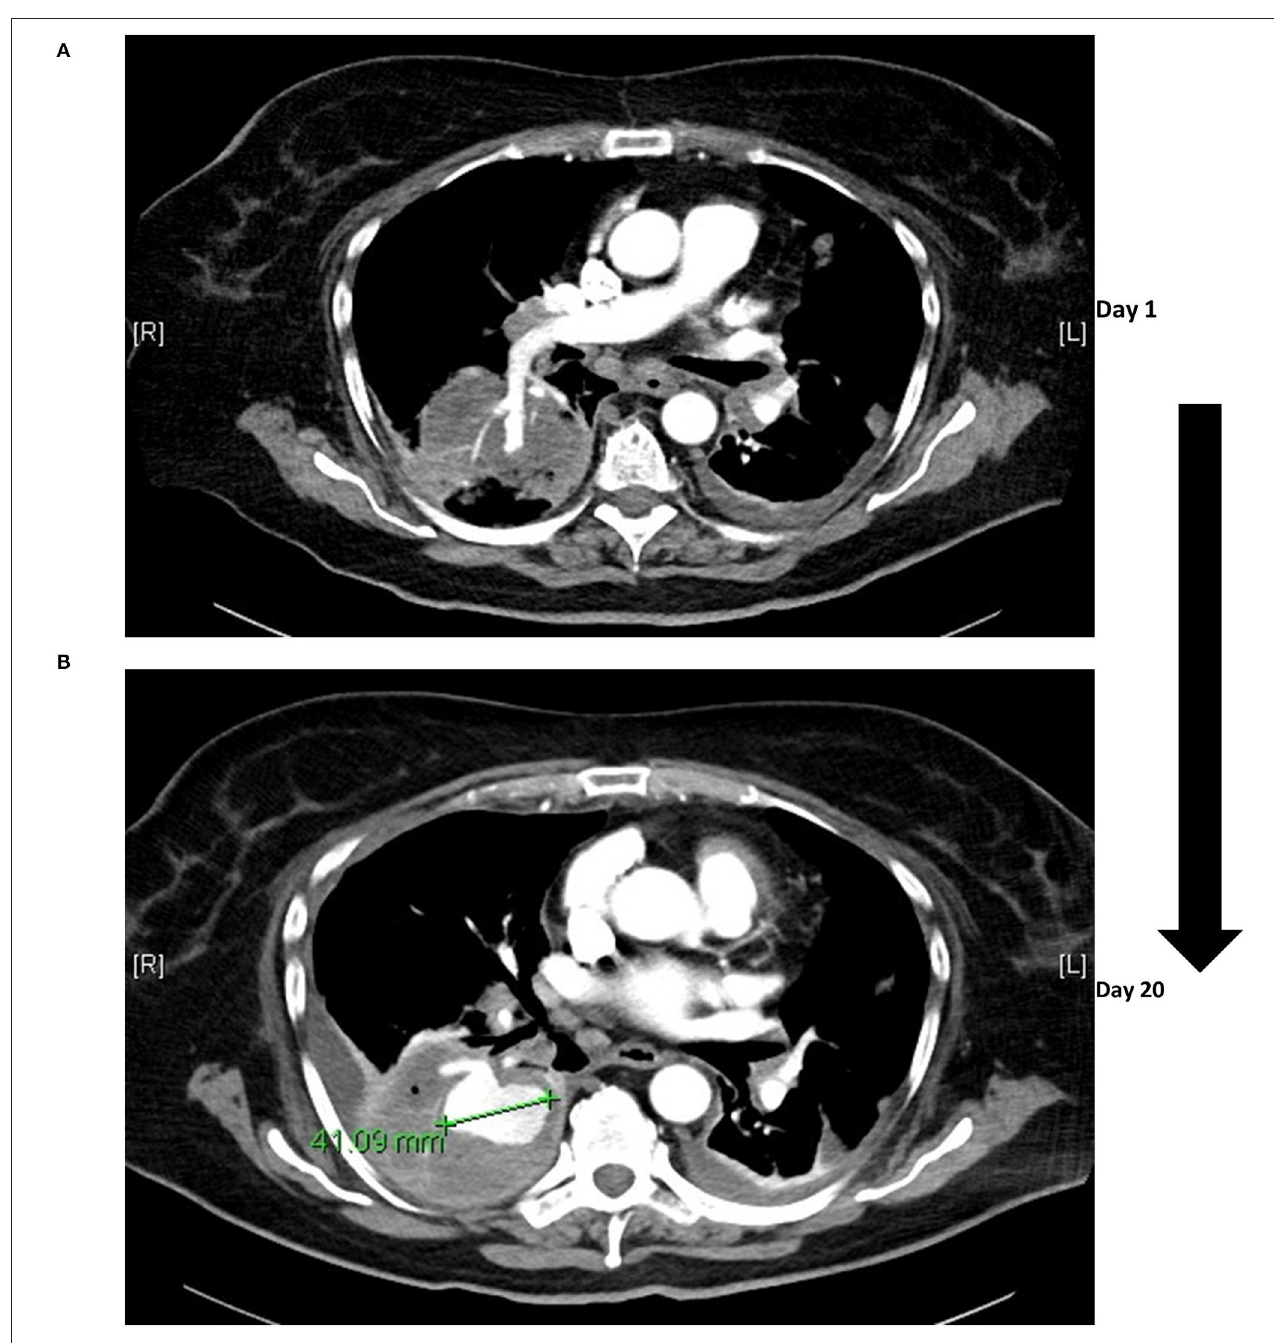
FIGURE 2 | Infectious aneurysm of the pulmonary artery. The initial computed tomography was performed on the day of admission (A) with solely consolidation in the right basal lobe and an accentuated right lower lobe pulmonary artery. Over the course of 20 days an infectious pulmonary arterial aneurysm manifested with a diameter > 4cm (B) , coinciding with clinical signs of